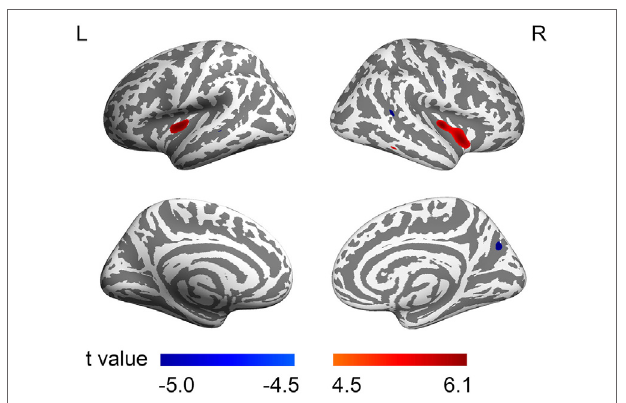
FigUre 1 | Brain regions with abnormal cortical thickness (CT) in male youths with Internet gaming disorder (IGD). The warm color denotes the brain regions having increased CT, and the cold color denotes the brain regions having decreased CT in youths with IGD. The colored bars show t values. L, left; R,